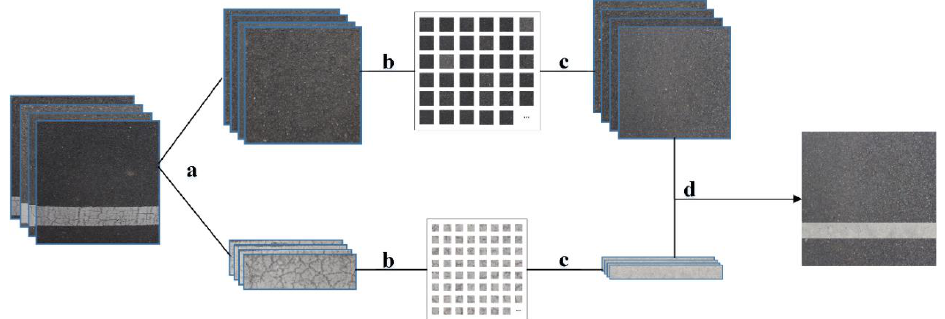
Figure 2. The framework of label images generation. Firstly, the lane and asphalt pavement in the original road image are separated manually ( a ), then the two type images are cut into small fragments ( b ). Then a large number of road and lane images are synthesized by the proposed improved Image Quilting method ( c ). Finally, the label images are synthesized according to the pixel distance between the lane strip and the asphalt pavement image ( d